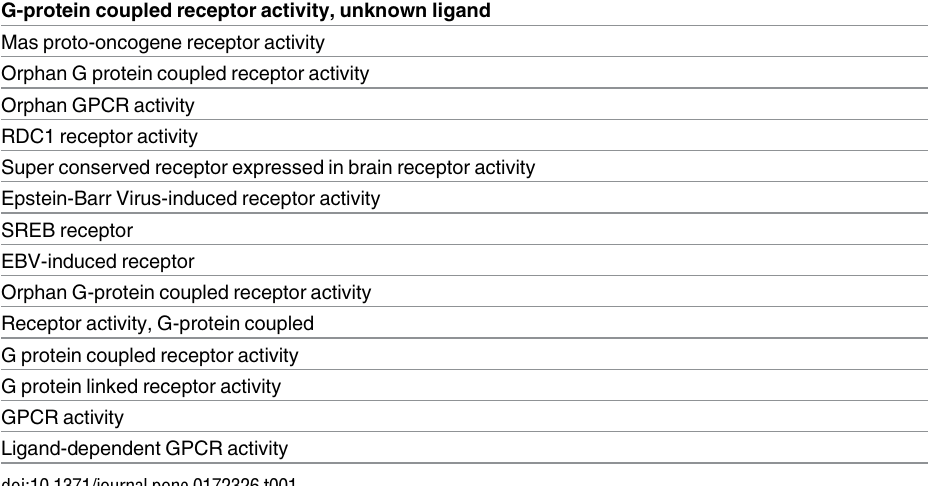
Table 1. GPCR Synonyms (GO:0004930) and terms associated with GPCR